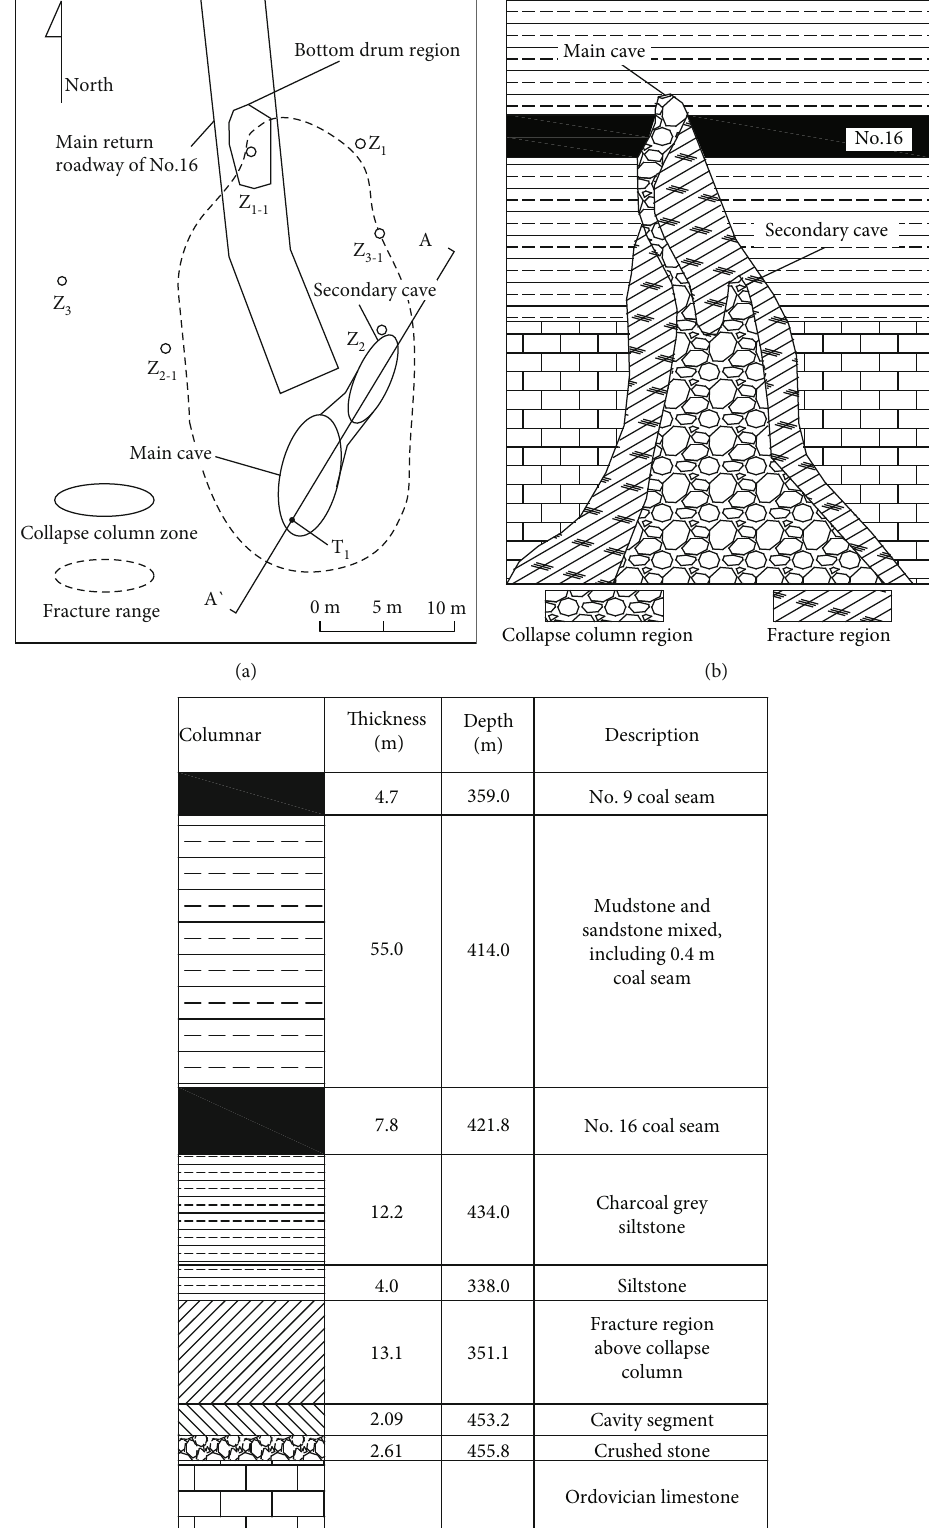
Figure 2: Plane view (a) and A-A section view (b) of the collapse column; (c) stratigraphic structure diagram of T